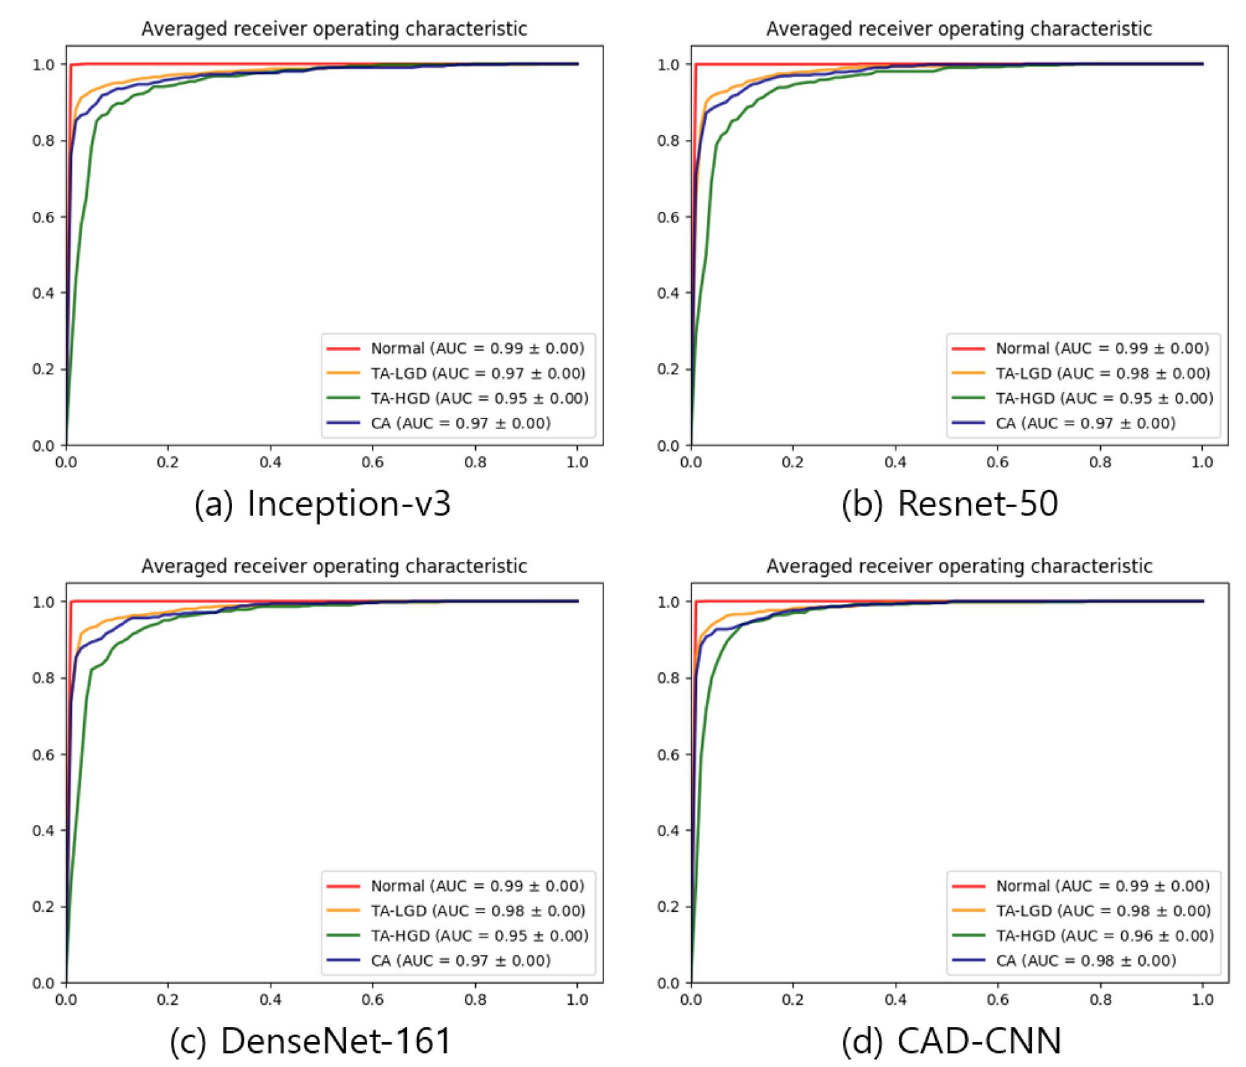
Figure 5. Receiver operating characteristics (ROCs) curves of tenfold cross-validation with the KUMC data set. The 10 cross-validation models which show the best validation accuracy during 300 training epochs are evaluated. The area under curve (AUC) is also listed for each category. ( a ) Inception-v3. ( b ) Resnet-50. ( c ) DenseNet-161. ( d ) CAD-CNN.